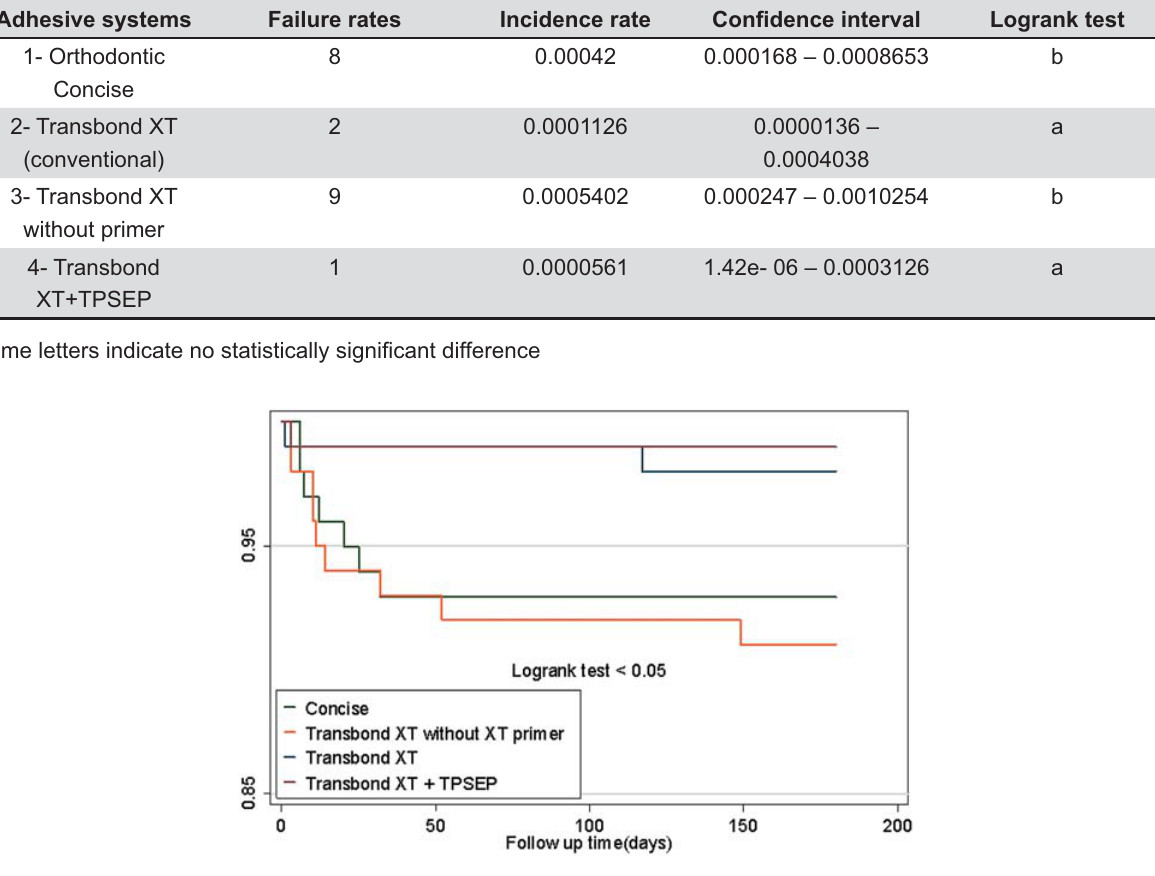
Figure 3- Kaplan-Meier survival curve for brackets bonded using the different adhesive